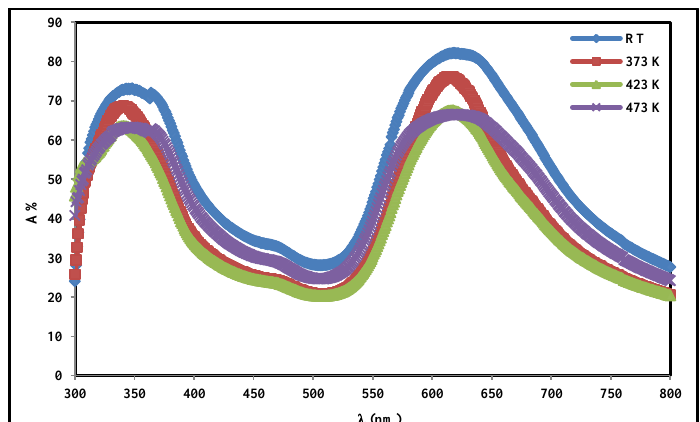
Fig.4: Absorption spectra of as-deposited and annealed blend NiPcTs/Alq